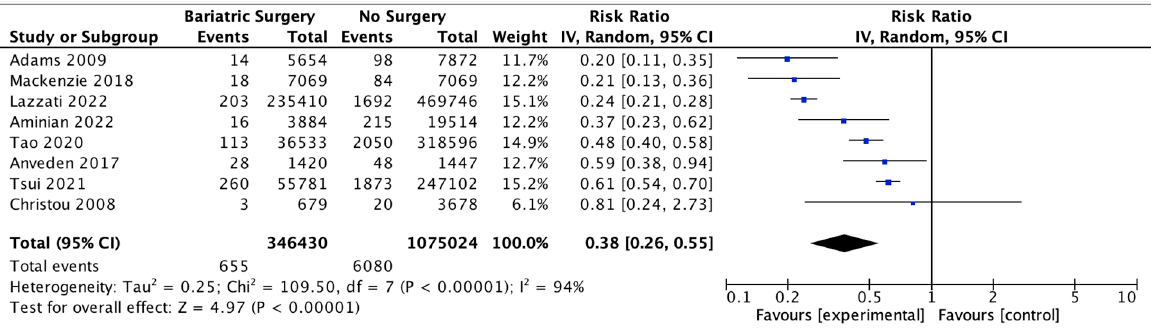
Eight studies reported on endometrial cancer incidence, with 346,430 female patients in the bariatric surgery cohort compared to 1,075,024 female patients in the control group. Bariatric surgery was associated with a signi fi cant reduction in the incidence of endome- trial cancer (RR 0.38, 95% CI 0.26–0.55, p < 0.00001). There was statistically signi fi cant het- Figure 6. Breast cancer incidence [38–40,43,45,49,50,53–57,62]. Figure 6. Breast cancer incidence [38–40,43,45,49,50,53–57,62]. erogeneity across the studies (Chi 2 = 109.50, p <0.00001, I 2 = 94%) (Figure 7).